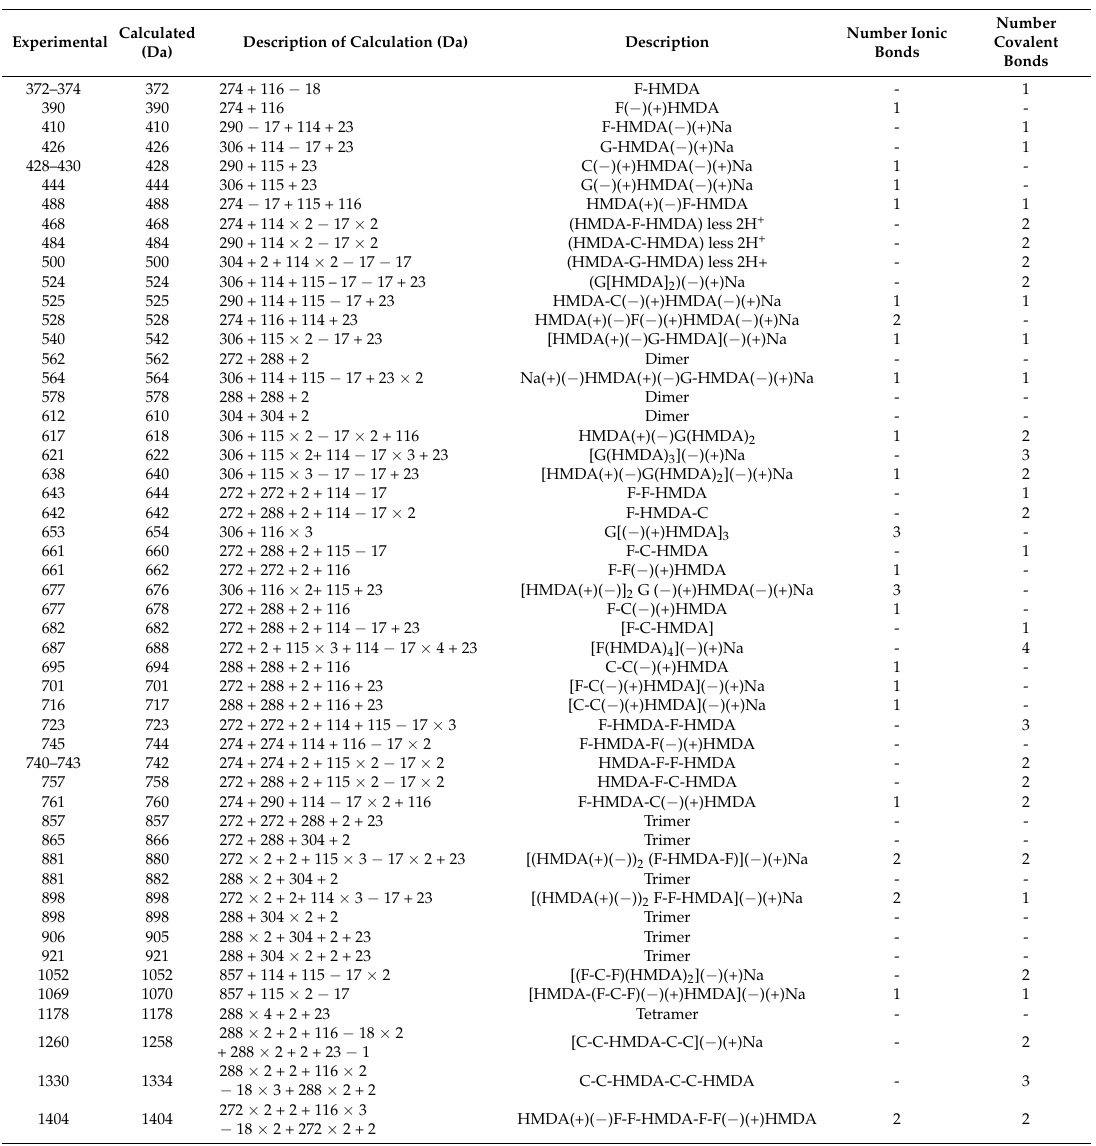
Table 2. Oligomer species formed during the reaction at 100 ◦ C between mimosa tannin extract and hexamethylene diamine in the NaOH-catalysed